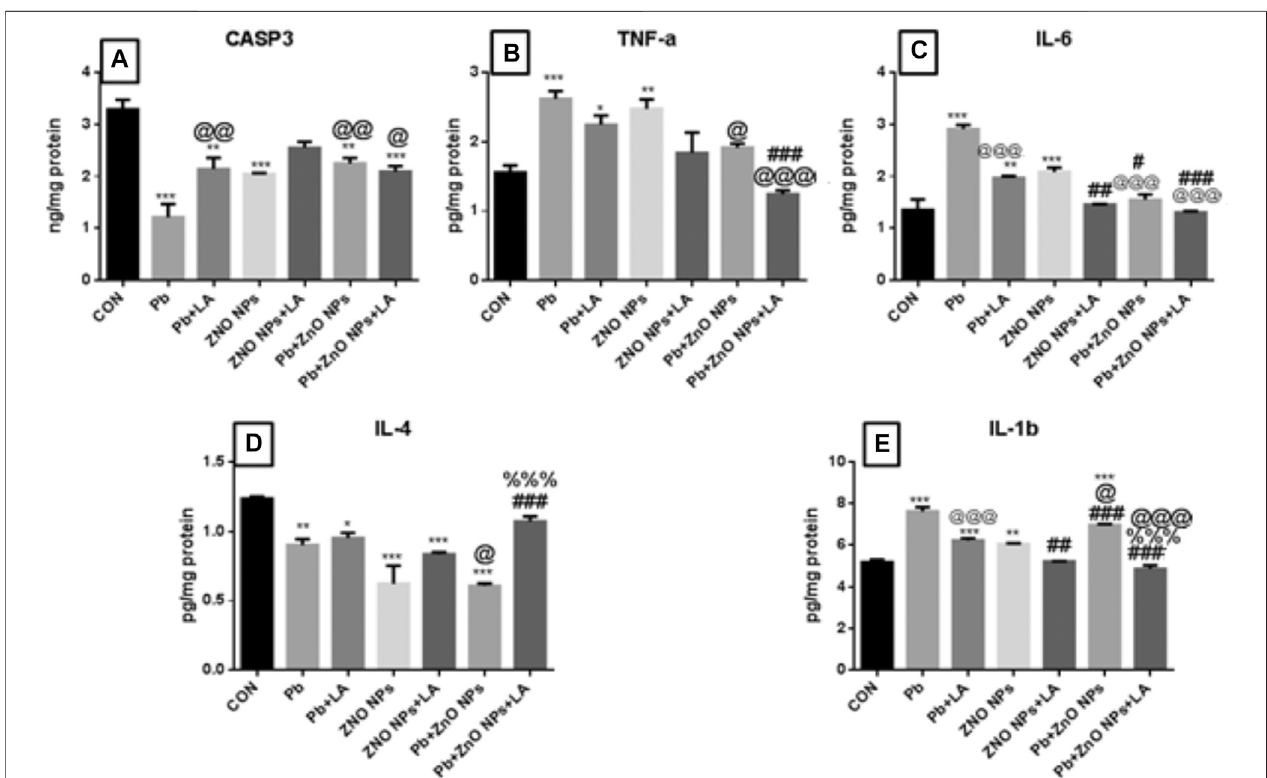
FIGURE 12 | Rat brain caspase-3 and cytokine levels. (A) CASP3; (B) TNFa; (C) IL-6; (D) IL-4; and (E) IL-1b. All the values are expressed as mean ± SEM (n (cid:2) 4). Thestatisticalsigni fi cancewasconsideredat p < 0.05andstatisticalanalysiswasperformedusingone-wayANOVA,followedbyTukey ’ stest.* p < 0.05, ** p < 0.01, *** p